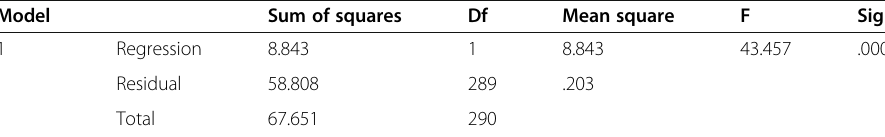
Table 10 ANOVA b